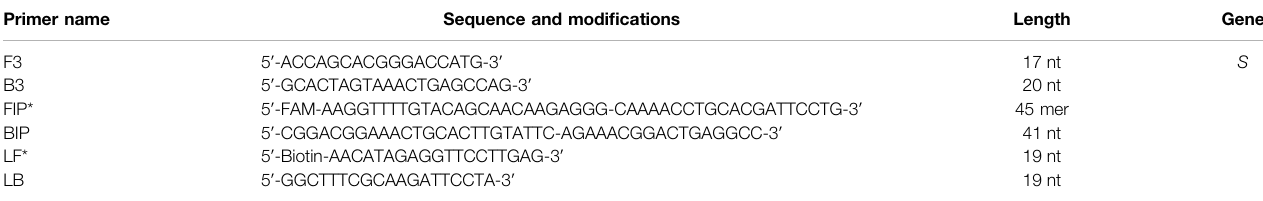
TABLE 2 | The primers used in the present